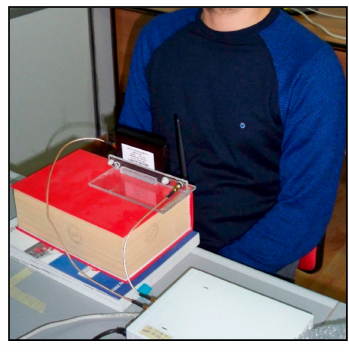
Figure 6. Experimental setup for the monitoring of the respiration activity.